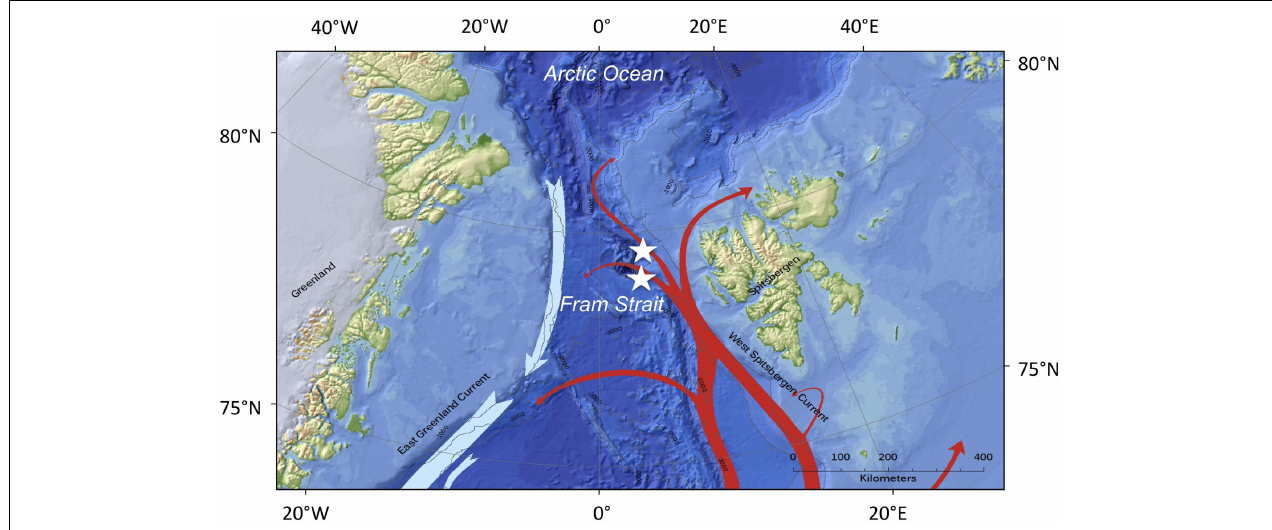
FIGURE 1 | Schematic map of the marine circulation patterns in the Fram Strait. The West Spitsbergen Current is delineated by red arrows; the East Greenland Current is depicted by light blue arrows. The stars in the center indicate the two mooring positions, North (upper asterisk) and Central (lower asterisk), in the LTER observatory HAUSGARTEN. The map was created using ArcGIS 10.3 and based on the General Bathymetric Chart of the Oceans (GEBCO)-08 grid, version 20100927, http://www.gebco.net, with permission from the British Oceanographic Data Centre (BODC). TABLE 1 | Location, sampling time, water depth, and trap depth of moored sediment traps in the HAUSGARTEN and Greenland Sea analyzed for their amphipod composition with multivariate analyses. Mooring period in year s Lat. N Long. E Water depth Trap depth ( m ) Number of samples